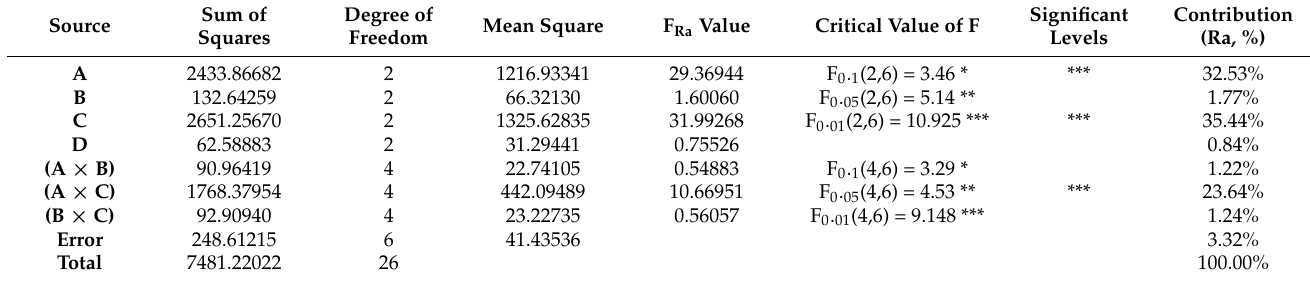
Table 7. ANOVA analysis for Ra.